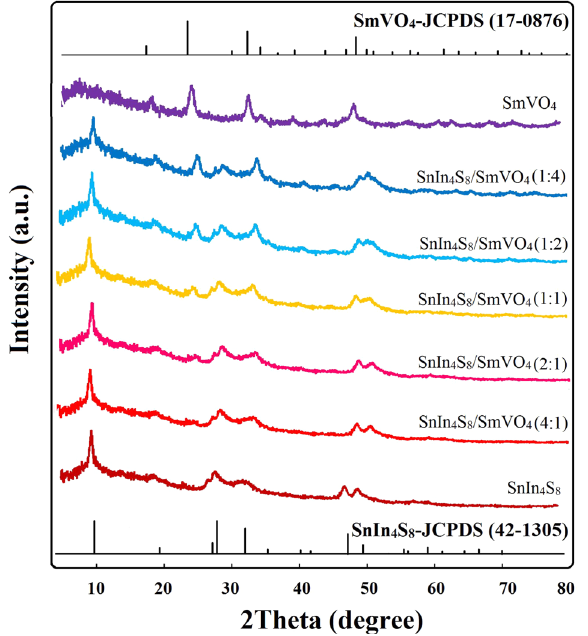
Fig. 1 XRD patterns. SnIn 4 S 8 . SmVO 4 . SnIn 4 S 8 /SmVO 4 .